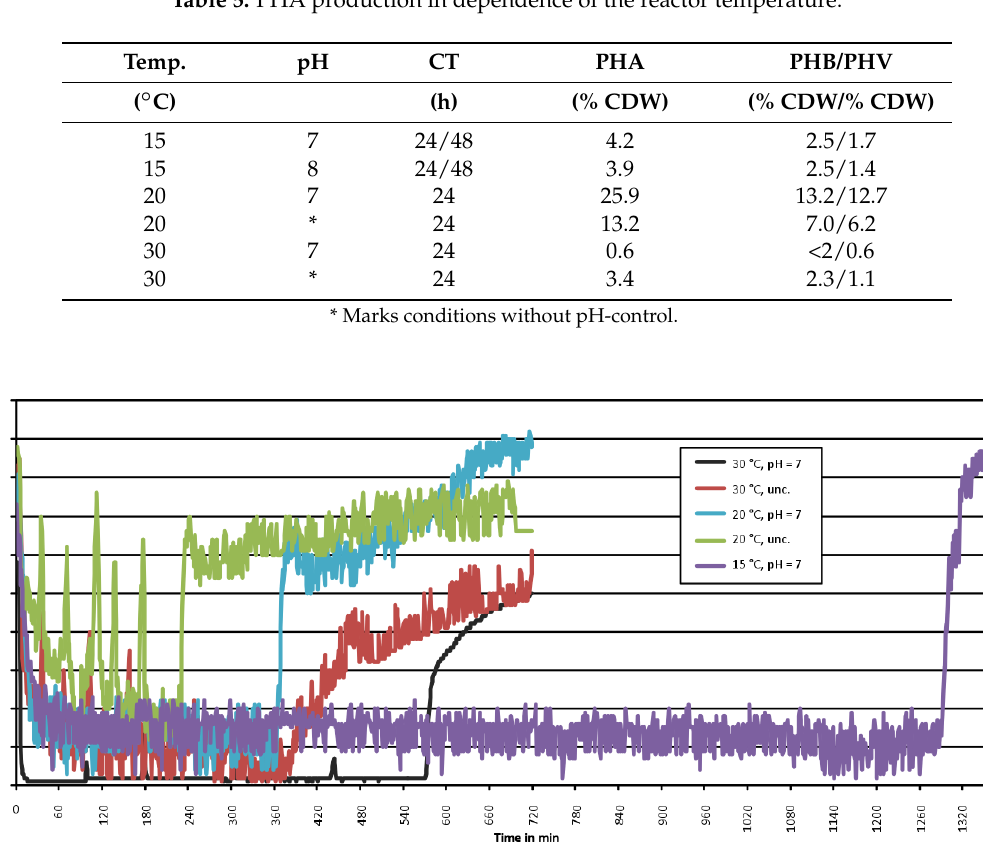
Table 5. PHA production in dependence of the reactor temperature.